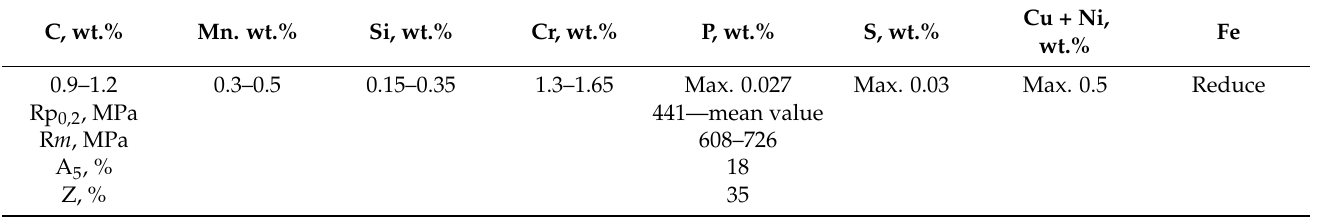
Table 1. Permissible chemical composition and mechanical properties of used steel, specified as STN 14 109 standard